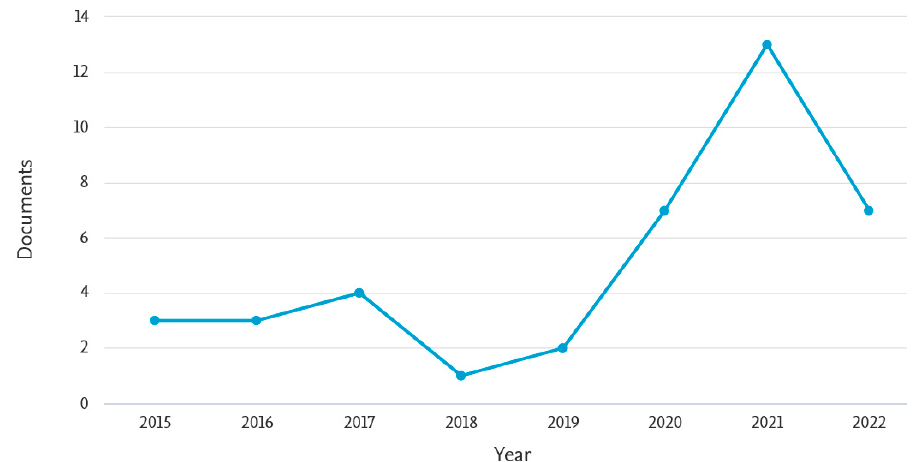
Figure 3. Distribution of papers by year (adopted from Scopus).